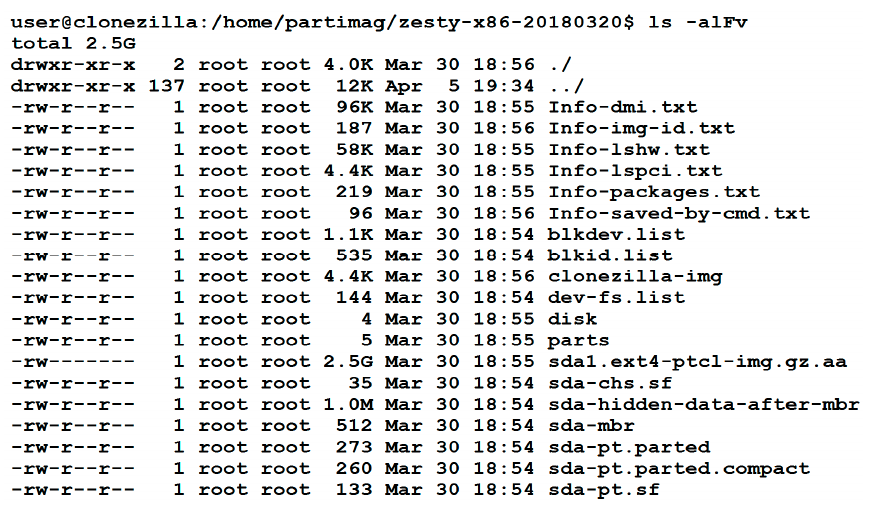
Figure 3. Screenshot of the files in an image directory that was saved by Clonezilla.